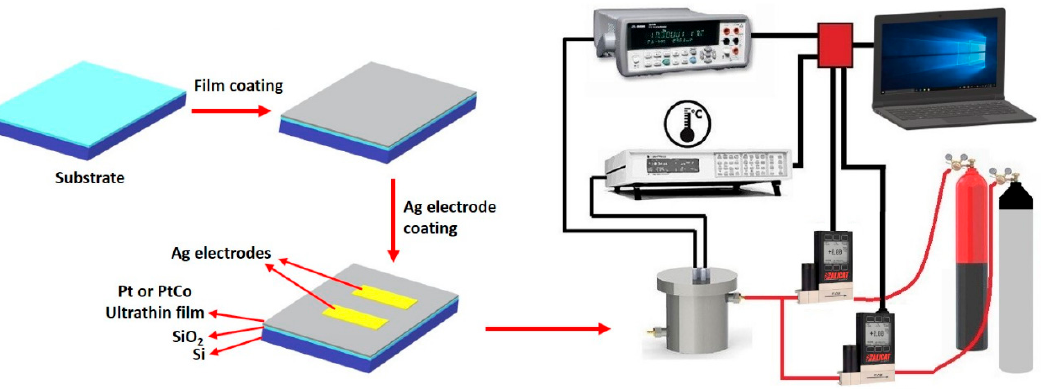
Figure 1. A schematic diagram for fabrication of sensor device and gas-sensing measurement setup.